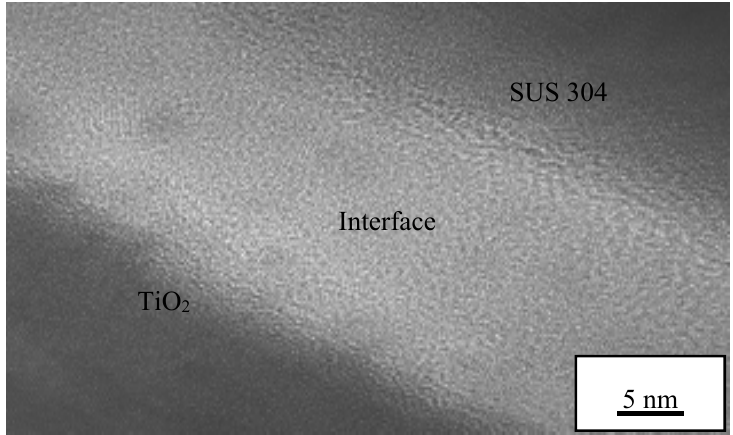
Figure 10. High-magnification images of the TiO 2 /1000 °C annealed SUS 304 interface at the bonded region, B.